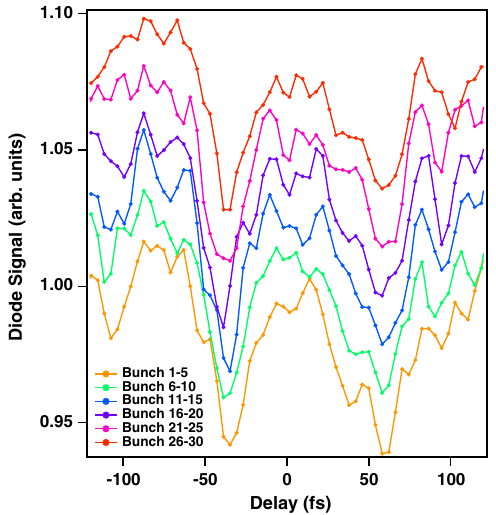
FIG. 10. Plotted is the XUV reflectivity of a solid target (Si 3 N 4 ) as a function of the relative delay between the two pulses for groups of five bunches in the bunch train. Each data point is the average of about 210 single events giving an overall measurement time of about 5 min for the whole data set. The bunch-resolved (in groups of five bunches) autocorrelation signal for a solid target (Si 3 N 4 ) is shown. For each data point, 210 XUV pulses were summed. The figure shows the XUV reflectivity measured as a function of the delay between the two pulses. The data were recorded for a wavelength of 13.5